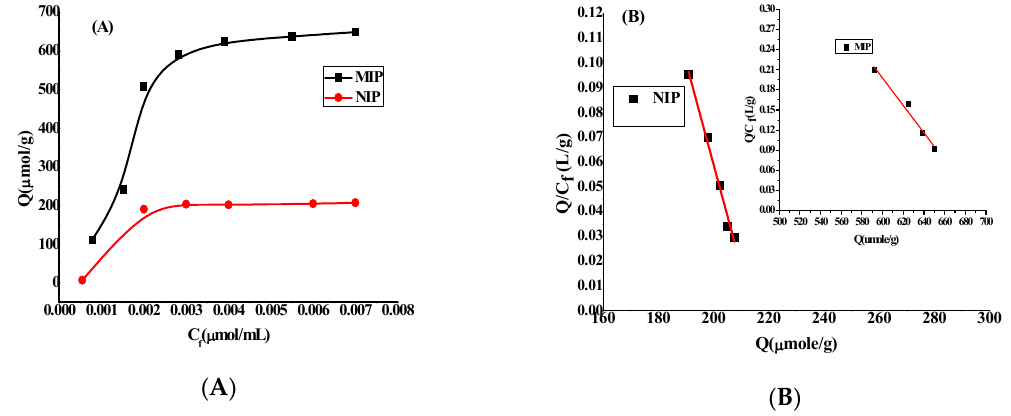
Figure 4. ( A ) Binding isotherm and ( B ) Scatchard plot for MIP and NIP.